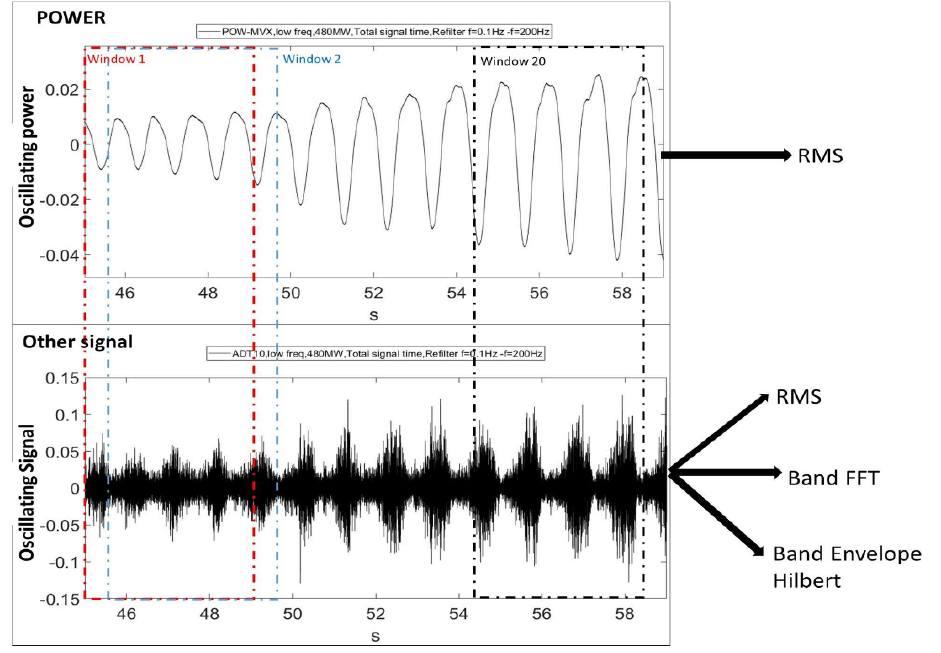
Figure 10. Evaluation of the acquisition